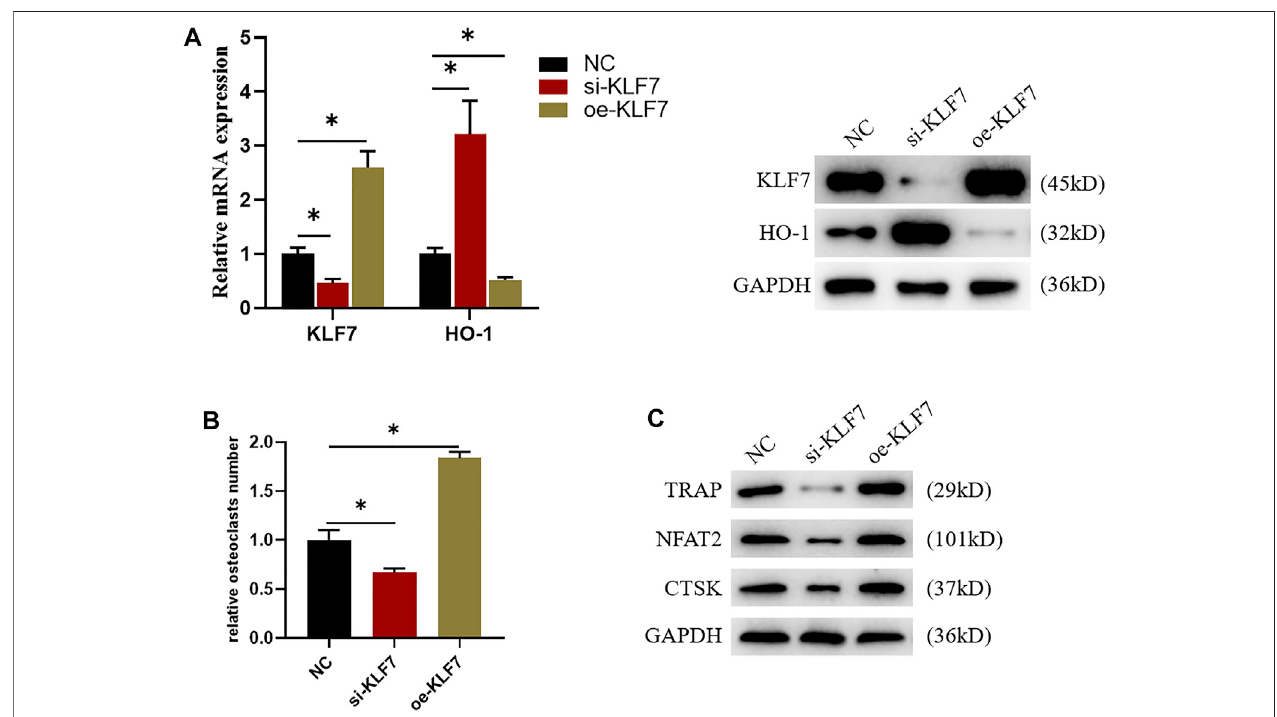
FIGURE 3 | KLF7 can regulate osteoclast differentiation. (A) Protein and mRNA expression levels of KLF7 and HO-1 after si-KLF7 and oe-KLF7 treatment. (B) TRAP staining showed that macrophage differentiation could be affected by silencing and overexpressing KLF7. (C) Changes of the expression levels of osteoclast markers after KLF7 silence and overexpression. * p <